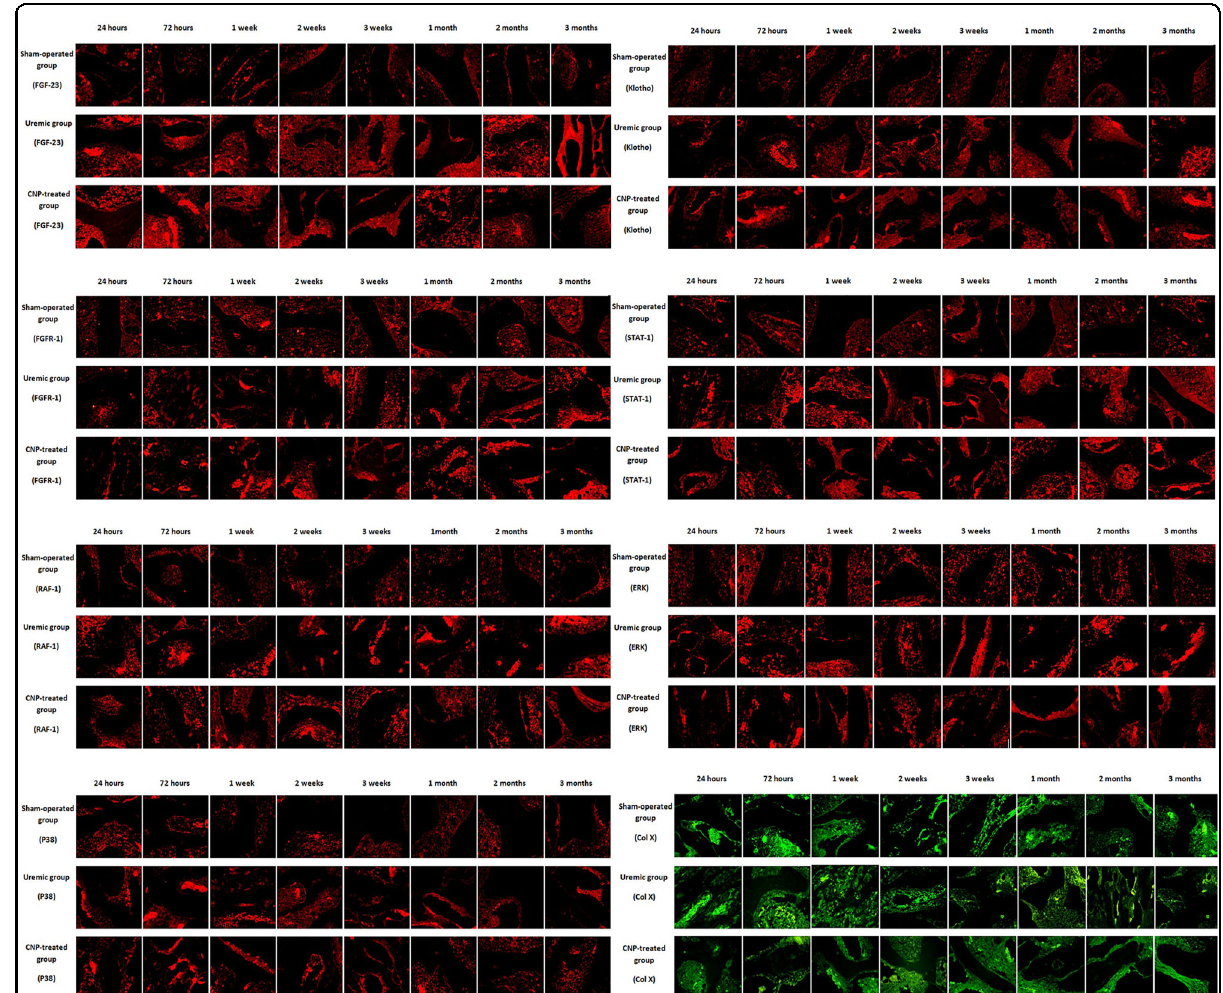
Fig. 7 Immuno fl uorescence staining of FGF-23, Klotho, FGFR-1, STAT-1, RAF-1, ERK, P38, and Col X proteins in sham-operated, uremic, and CNP-treated rats. Uremic group vs. sham-operated group: There was no signi fi cant difference in positive immunostaining for FGF-23 between the two groups from 24 h to 1 month, whereas the divergence increased in a time-dependent manner and initially reached signi fi cance at 2 months. CNP-treated group vs. uremic group: Compared with the uremic group, the CNP-treated group showed higher positive immunostaining for Klotho, FGFR-1, STAT-1, and Col X proteins in the osteocytes in the chronic stage. In contrast, staining for RAF-1 and P38 protein was noticeably suppressed by CNP and displayed in a dot-linear manner after the acute